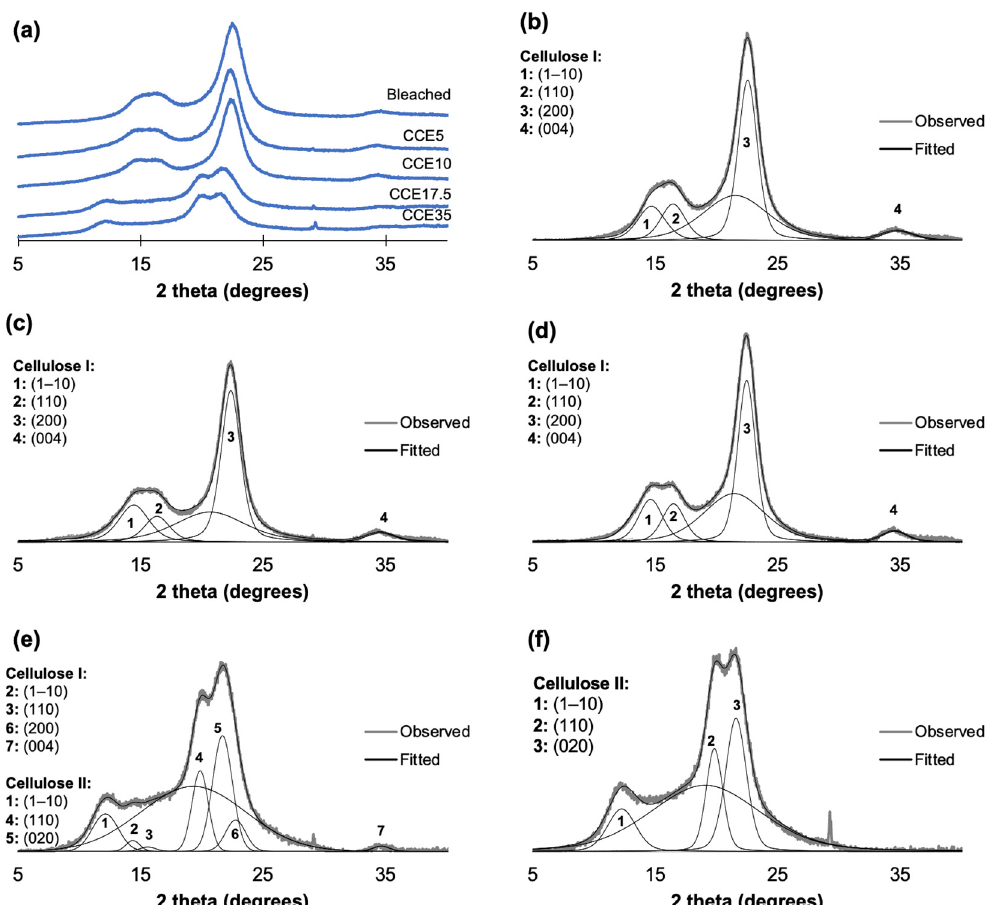
Figure 4. Pine XRD diffractograms. ( a ) XRD diffractograms of pine pulp after alkaline treatment, ( b ) curve-fitting of bleached kraft pulp, ( c ) curve-fitting of CCE5, ( d ) curve-fitting of CCE10, ( e ) curve-fitting of CCE17.5, and ( f ) curve-fitting of CCE35 pine sample.